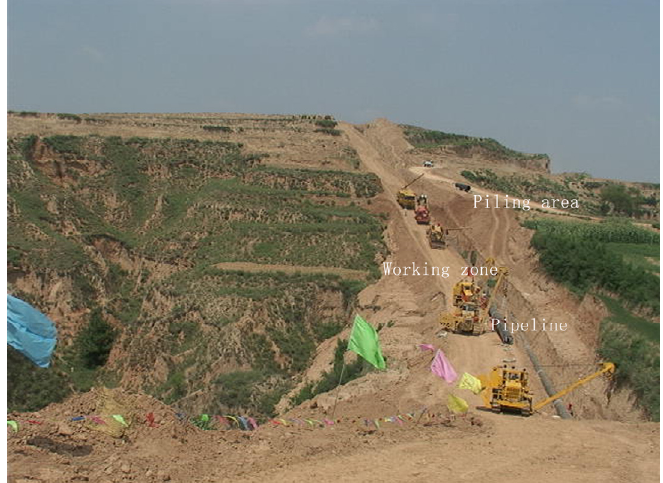
Figure 2. Pipeline right-of-way including trench, piling area and working